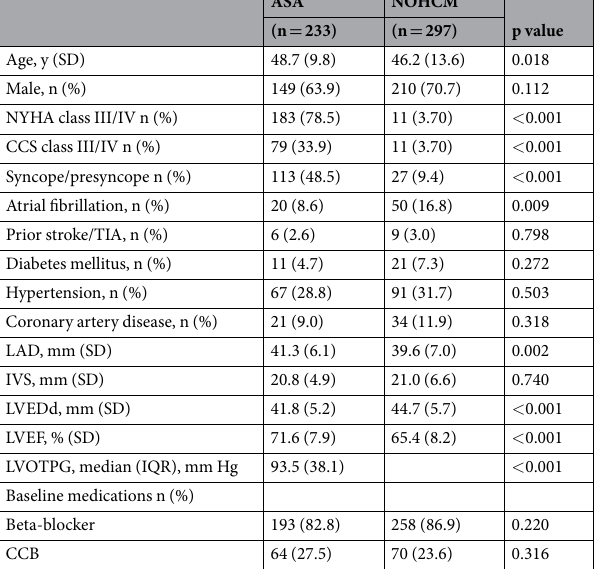
Table 1. Baseline Characteristics. ASA, alcohol septal ablation; NOHCM, non obstructive hypertrophic cardiomyopathy; NYHA, New York Heart Association; CCS, Canadian Cardiovascular Society; LAD, left atrial diameter; IVS, intra-ventricular septal thickness; LVEDd, left ventricular end-diastolic diameter; LVEF, left ventricular ejection fraction; LVOTPG, left ventricular outflow tract pressure gradient; SD, standard deviation; CCB, calcium channel